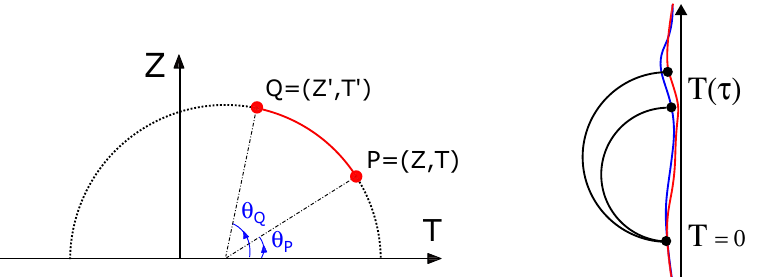
Figure 13 . Left: Euclidean geodesics are circle segments. Right: geodesic with endpoints on the holographic boundary at proper time τ apart. In Poincar´e coordinates, these endpoints are at T = 0 and T ( τ ), and the geodesic changes when changing off-shell time reparametrization T ( τ ) (blue and